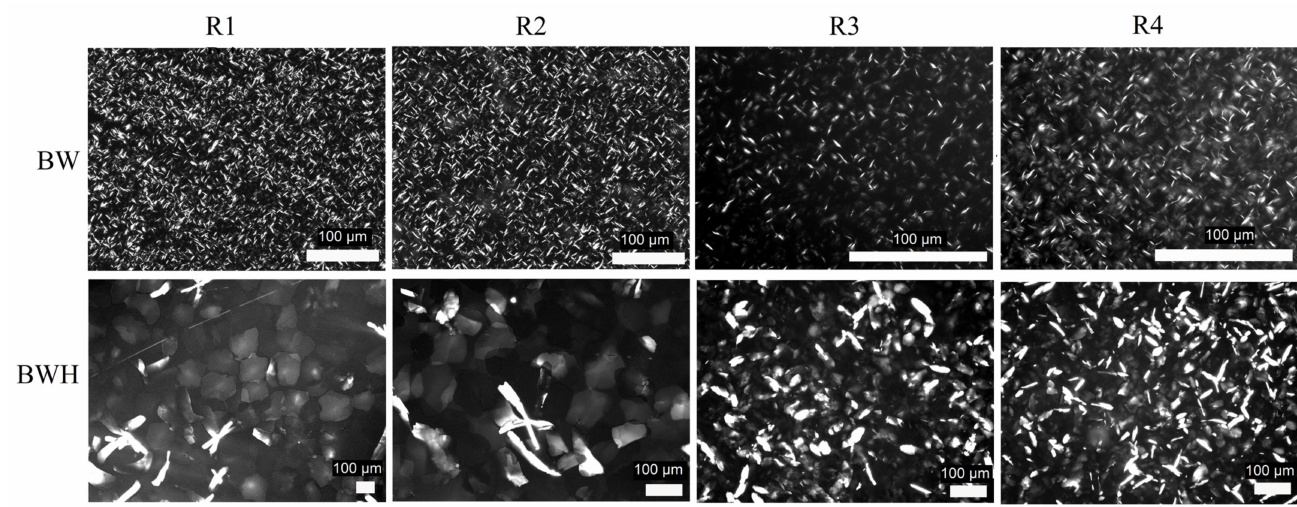
Figure 1. Representative microphotographs of beeswax and beeswax hydrocarbon-based oleogels pre- pared with different cooling regimes (Plan-Apochromat lens with 5 × (BWH R1), 10 × (BWH R2-R3), 20 × (BW R1–R2), and 40 × (BW R3–R4)).